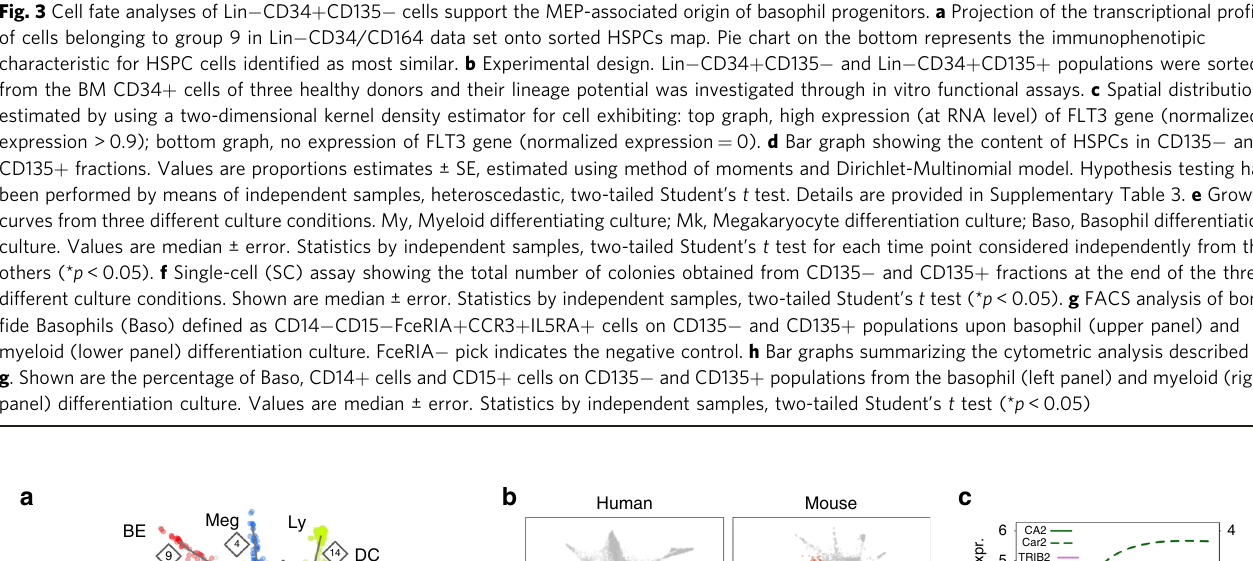
Fig. 3 Cell fate analyses of Lin − CD34 + CD135 − cells support the MEP-associated origin of basophil progenitors. a Projection of the transcriptional pro fi le of cells belonging to group 9 in Lin − CD34/CD164 data set onto sorted HSPCs map. Pie chart on the bottom represents the immunophenotipic characteristic for HSPC cells identi fi ed as most similar. b Experimental design. Lin − CD34 + CD135 − and Lin − CD34 + CD135 + populations were sorted from the BM CD34 + cells of three healthy donors and their lineage potential was investigated through in vitro functional assays. c Spatial distribution estimated by using a two-dimensional kernel density estimator for cell exhibiting: top graph, high expression (at RNA level) of FLT3 gene (normalized expression > 0.9); bottom graph, no expression of FLT3 gene (normalized expression = 0). d Bar graph showing the content of HSPCs in CD135 − and CD135 + fractions. Values are proportions estimates ± SE, estimated using method of moments and Dirichlet-Multinomial model. Hypothesis testing has been performed by means of independent samples, heteroscedastic, two-tailed Student ’ s t test. Details are provided in Supplementary Table 3. e Growth curves from three different culture conditions. My, Myeloid differentiating culture; Mk, Megakaryocyte differentiation culture; Baso, Basophil differentiation culture. Values are median ± error. Statistics by independent samples, two-tailed Student ’ s t test for each time point considered independently from the others (* p < 0.05). f Single-cell (SC) assay showing the total number of colonies obtained from CD135 − and CD135 + fractions at the end of the three different culture conditions. Shown are median ± error. Statistics by independent samples, two-tailed Student ’ s t test (* p < 0.05). g FACS analysis of bona fi de Basophils (Baso) de fi ned as CD14 − CD15 − FceRIA + CCR3 + IL5RA + cells on CD135 − and CD135 + populations upon basophil (upper panel) and myeloid (lower panel) differentiation culture. FceRIA − pick indicates the negative control. h Bar graphs summarizing the cytometric analysis described in g . Shown are the percentage of Baso, CD14 + cells and CD15 + cells on CD135 − and CD135 + populations from the basophil (left panel) and myeloid (right panel) differentiation culture. Values are median ± error. Statistics by independent samples, two-tailed Student ’ s t test (* p < 0.05)